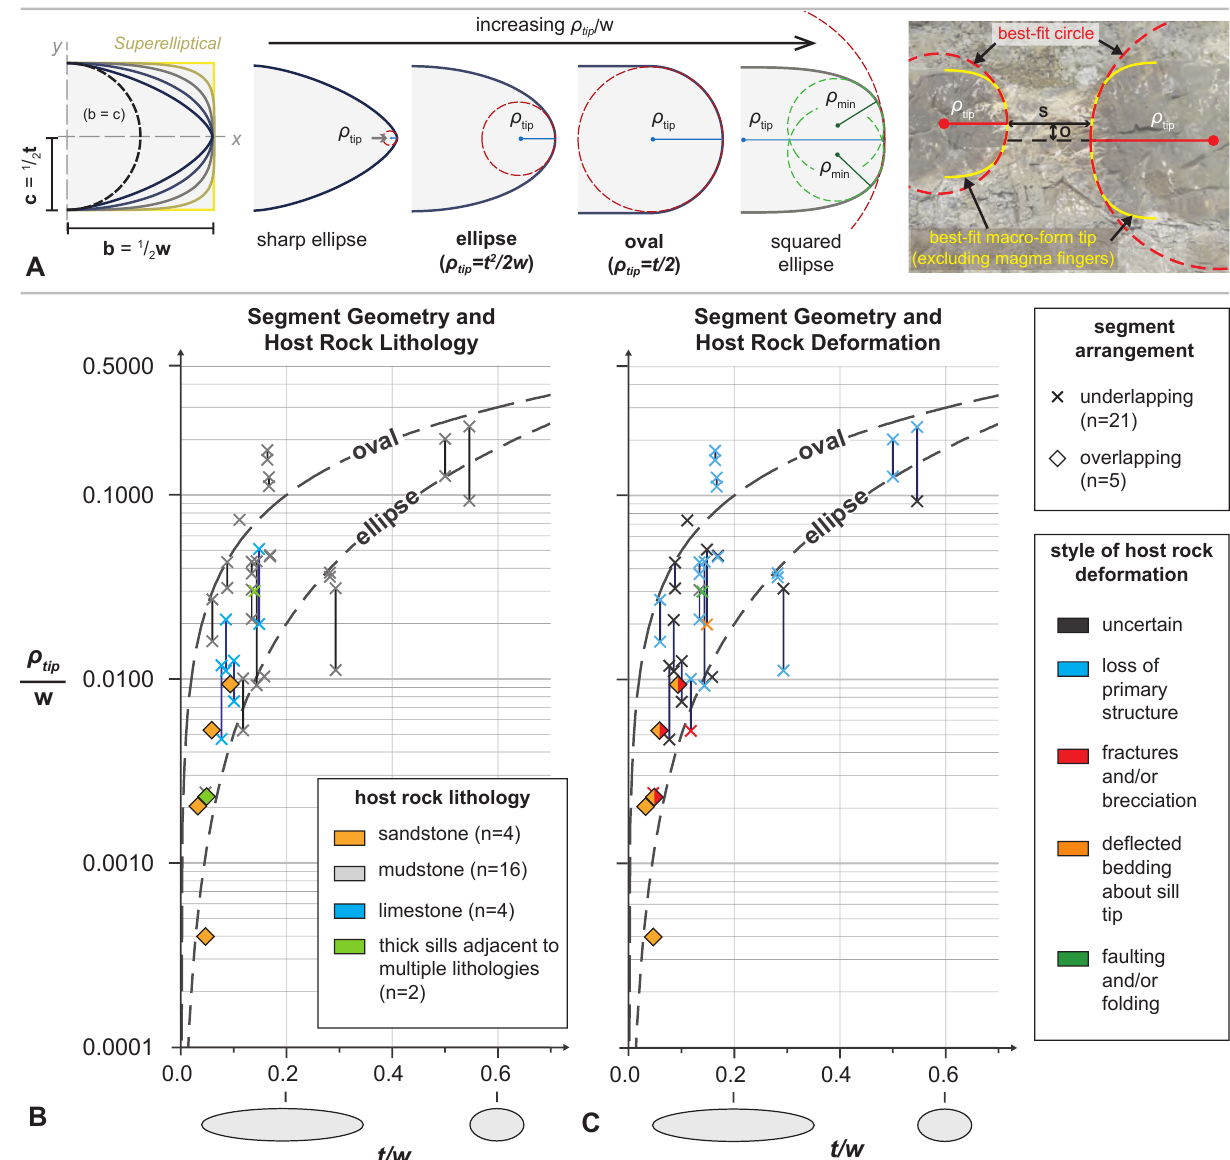
Figure 6: Geometrical characterisation of sill segment geometries in the Neist Point study area. [A] Schematic diagram to illustrate circular through to squared tip geometries and how the macro-tip form radius of curvature ( ρ ; red circle) was measured, with a worked field example. Note that once tip geometry surpasses an oval, cor- tip ners develop and the superelliptical geometry can also be defined by two minimum radii of curvature (see green circles in “squared ellipse” example); however only the macro-form tip geometry ( ρ ) is used here. Following the tip method of Pollard et al. [1975] the macro-tip forms were plotted and colour-coded to show: [B] segment geometry and host rock lithology; [C] segment geometry and observed style of localised host rock deformation ahead of the tip. Dashed lines for idealised oval and elliptical geometries are shown for comparison to measured geome- tries. Individual segments are shown as two data points (denoting the geometry of each tip) connected by a line; line length correlates to the segment asymmetry about its c-axis (longer line = more asymmetric); single (uncon- nected) points are where only one tip could be measured. Symbols indicate segment arrangement (underlapping or overlapping). Note that schematic segments below the x-axis in [B] and [C] are to illustrate segment t { w ratio only. (Data available in Supplementary File